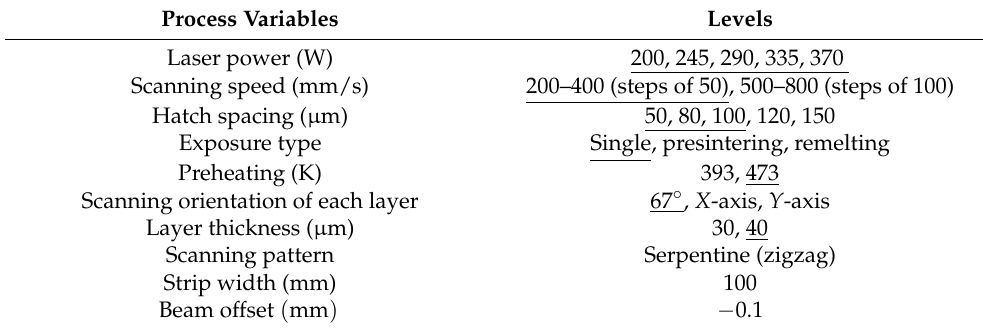
Table 3. List of process